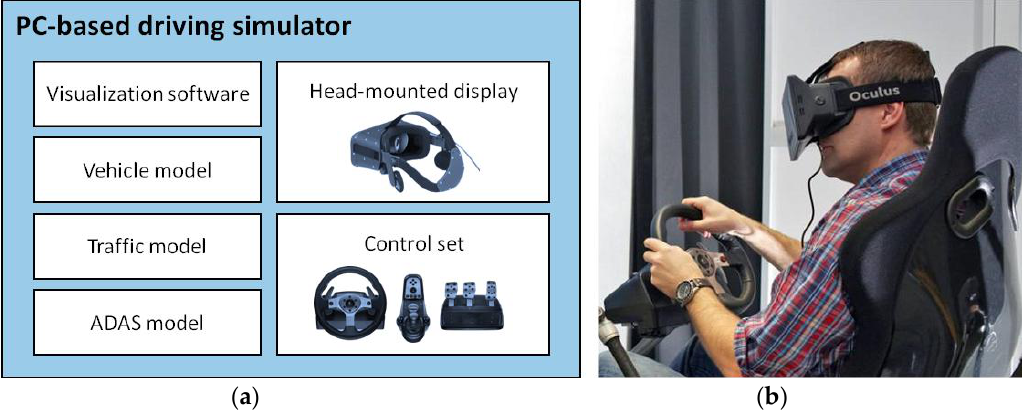
Figure 6. The integrated and further developed driving simulator: ( a ) The internal structure of the driving simulator; ( b ) A test driver experiencing virtual scenes using a head-mounted display. ADAS: Advanced Driver Assistance Systems.